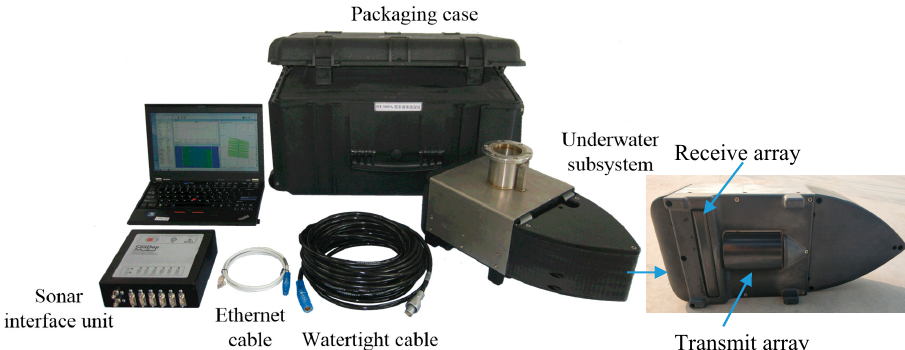
Remote Sens. 2020 , 12 , x FOR PEER REVIEW Figure 3. A photograph of HT300 PA MBES. Figure 3. A photograph of HT300 PA MBES.